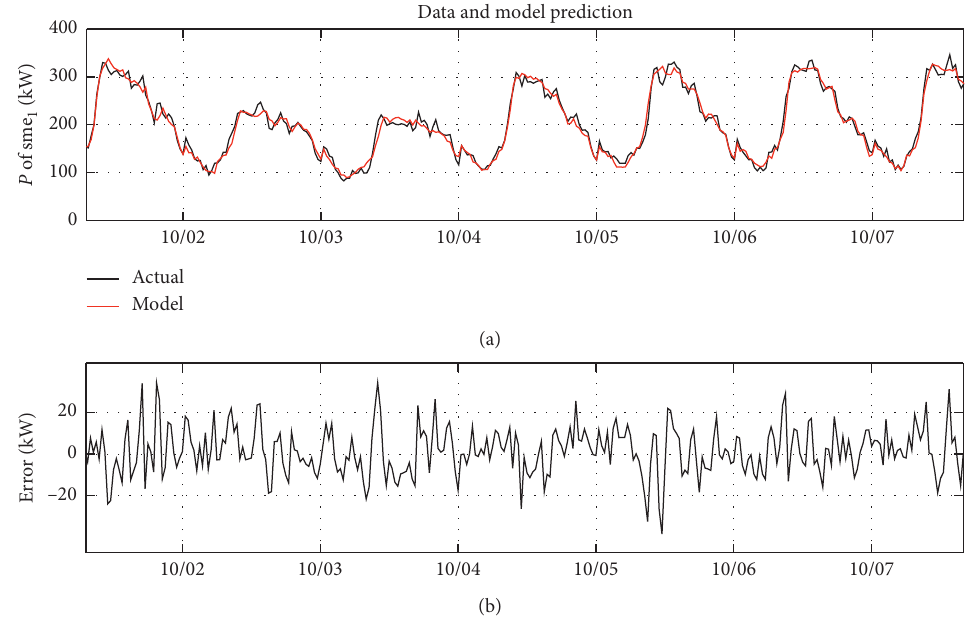
Figure 9: Detail of the first test week related to sme represents the actual one; (b) the corresponding error in